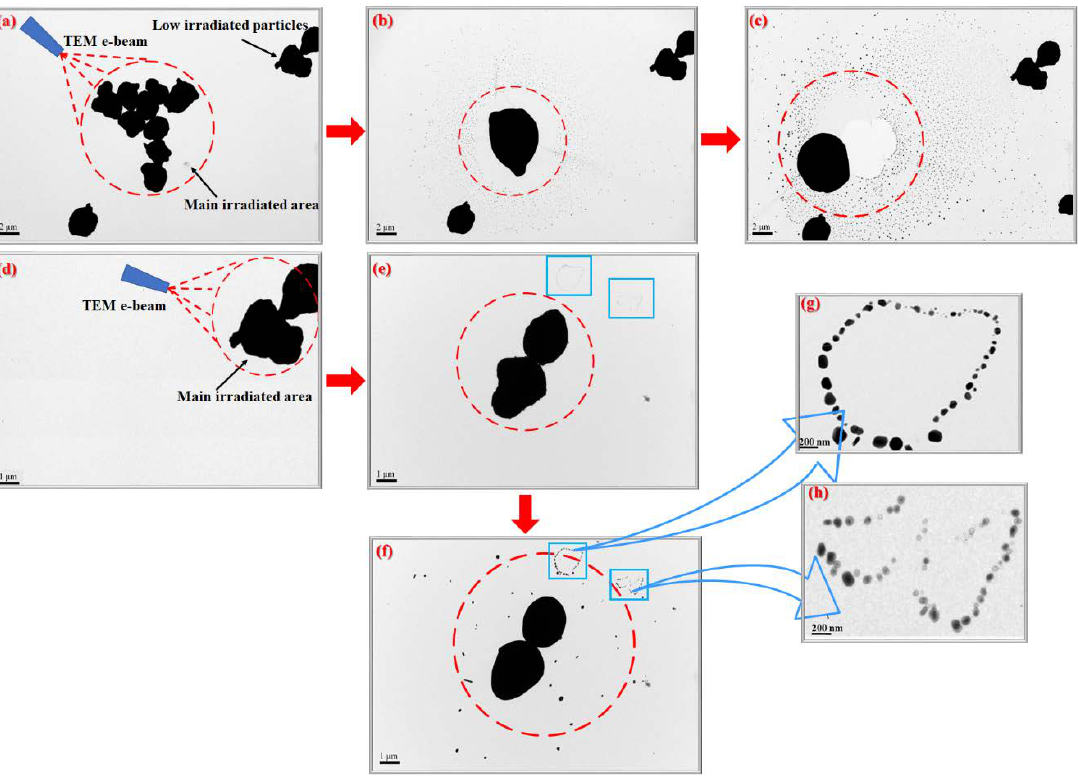
Figure 3. TEM micrographs of Cu-MPs prepared with molar ratio of TETA/Cu 2+ = 2.5/1 with different exposure times and irradiated areas: ( a ) in the beginning, ( b ) at 5 s, and ( c ) at 10 s; ( d ) magnified right-top area of ( a ), ( e ) 5 s, ( f ) 10 s later; ( g , h ) insets of two chosen magnified areas of ( f ).